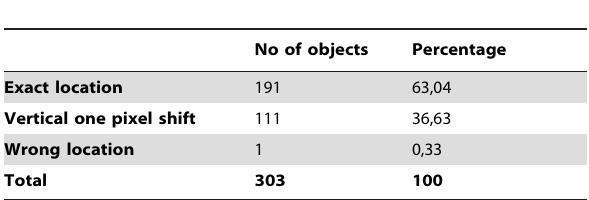
Table 2. Correlation peak relative position